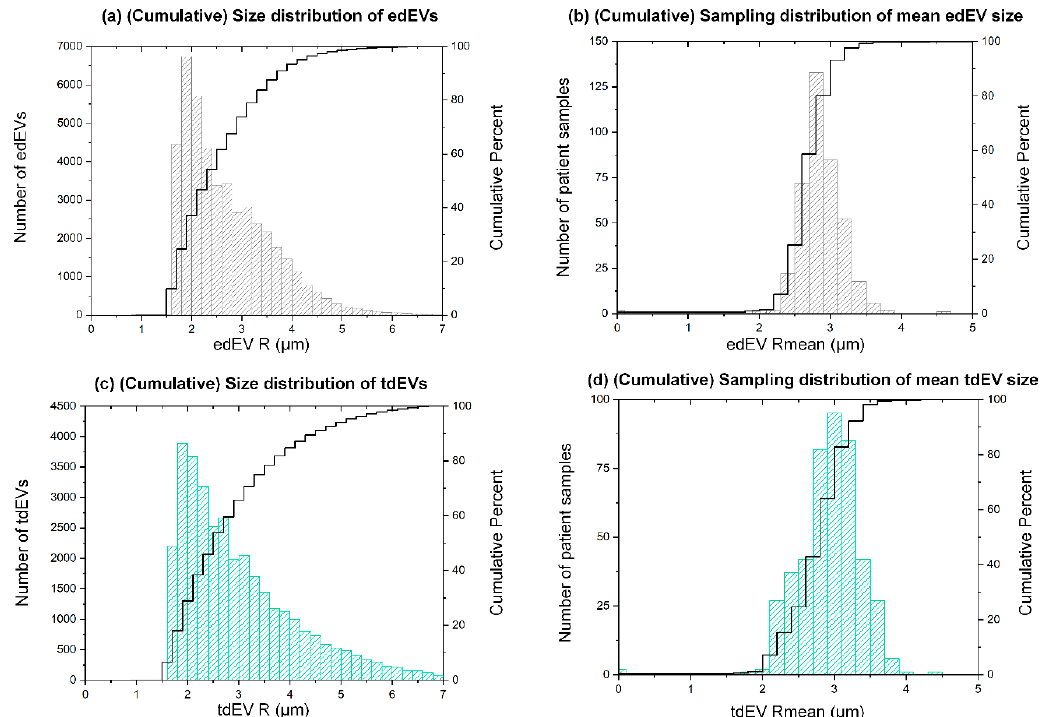
Figure 2. Size distribution of edEVs ( a ) and tdEVs ( c ) detected in 395 patient samples, derived from the respective CellSearch fluorescence images using the ACCEPT software. Sampling distributions of the mean edEV ( b ) and tdEV ( d ) size of 395 patient samples. The black lines correspond to the respective cumulative distributions.